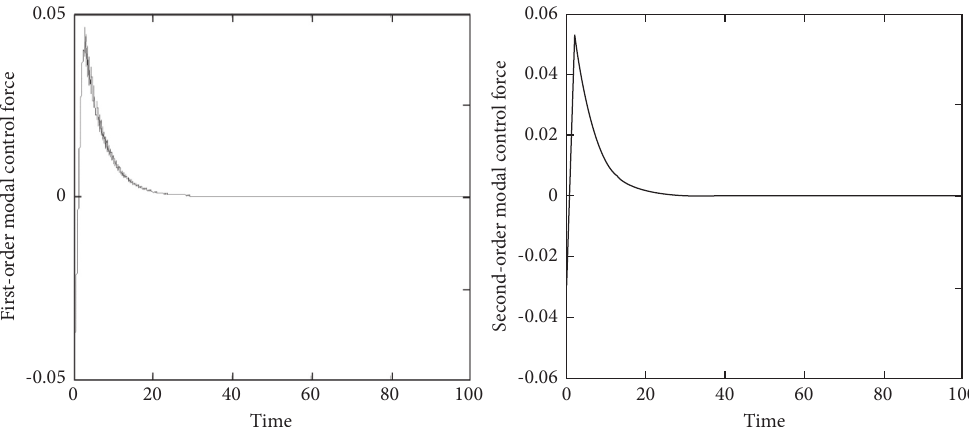
Figure 5: The time history of control inputs of the first two